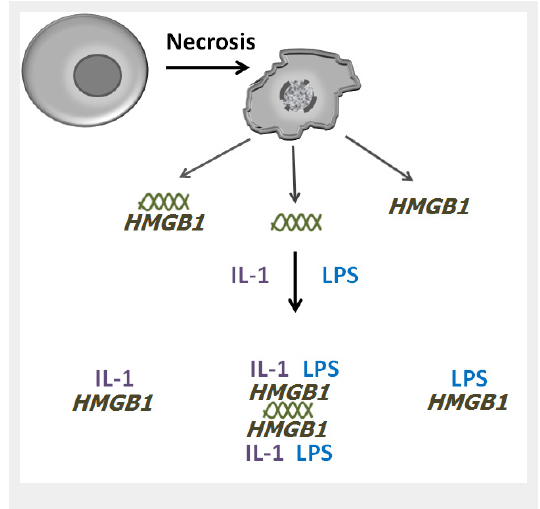
The formation of DAMP-PAMP complexes with HMGB1. The figure depicts a model by which HMGB1 can form complexes with DAMPs, PAMPs and cytokines following cell death. During necrosis in the setting of infection, both HMGB1 and DNA (illustrated by the double helix) can exit cells, alone or as a complex. Once in the extracellular milieu, HMGB1 can bind to molecules such as IL-1 and LPS and, depending on its interactions with DNA, can form complexes of varying structure and with a varying the number of components. The large complex illustrated is hypothetical although experimental data have demonstrated complexes of HMGB1 with DNA, IL-1 and LPS. This model allows the generation of many types of complexes that could vary depending on the components and the stoichiometry. For simplicity, the array of such complexes is not